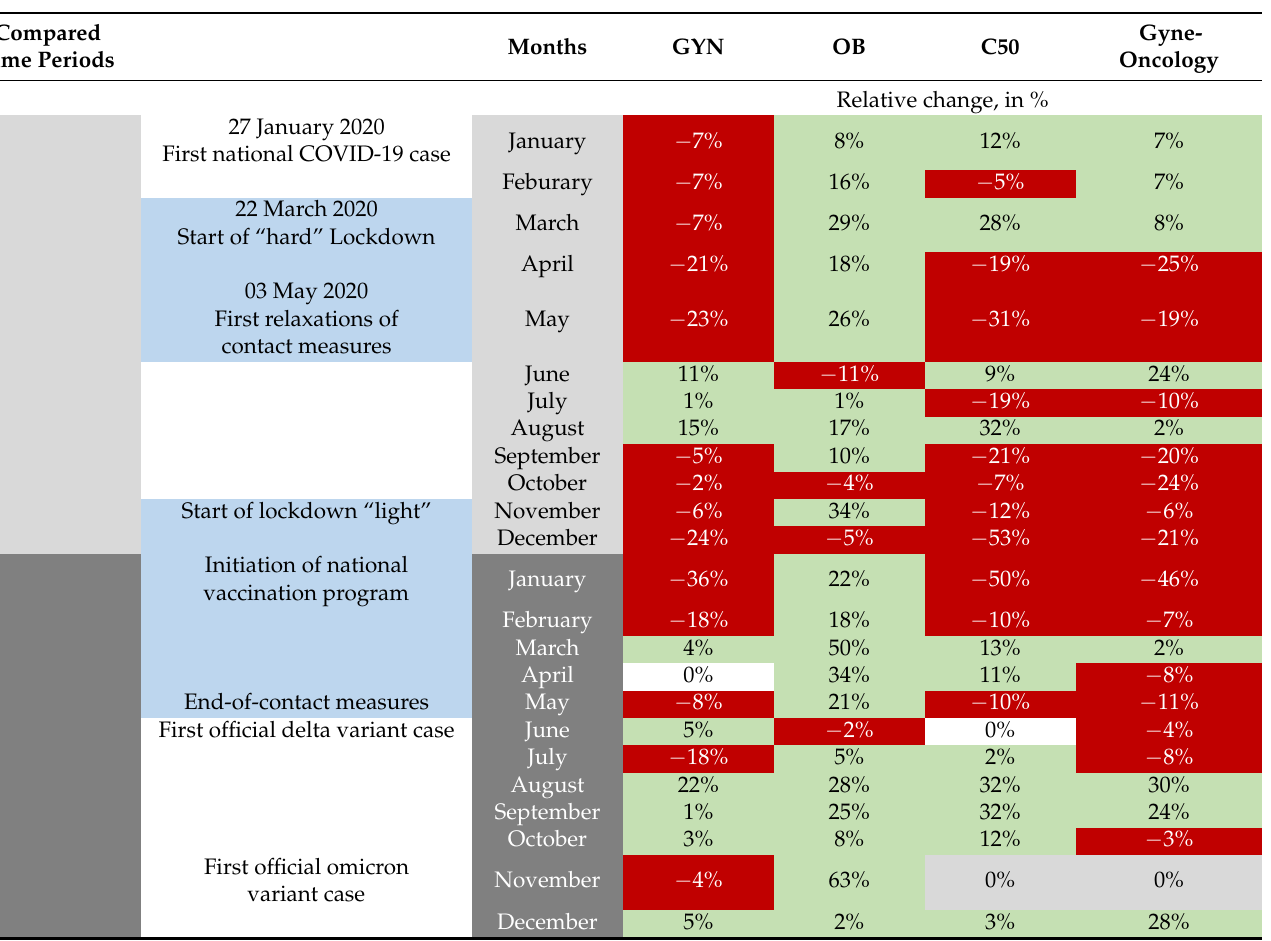
Table 3. Overview of the monthly relative case development of the gynecology, obstetrics, and gyne-oncology patient collectives (2019–2021) at Marburg University